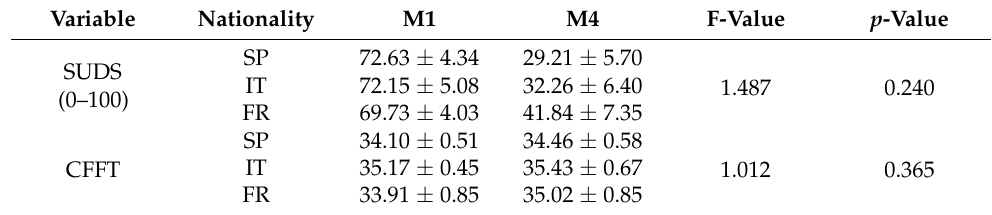
Table 2. Changes (Mean ± SD) in subjective units of distress (SUDS), critical flicker fusion threshold before (CFFT), and the expected academic achievement in the final thesis according to different nationality. Variable Nationality M1 M4 F-Value